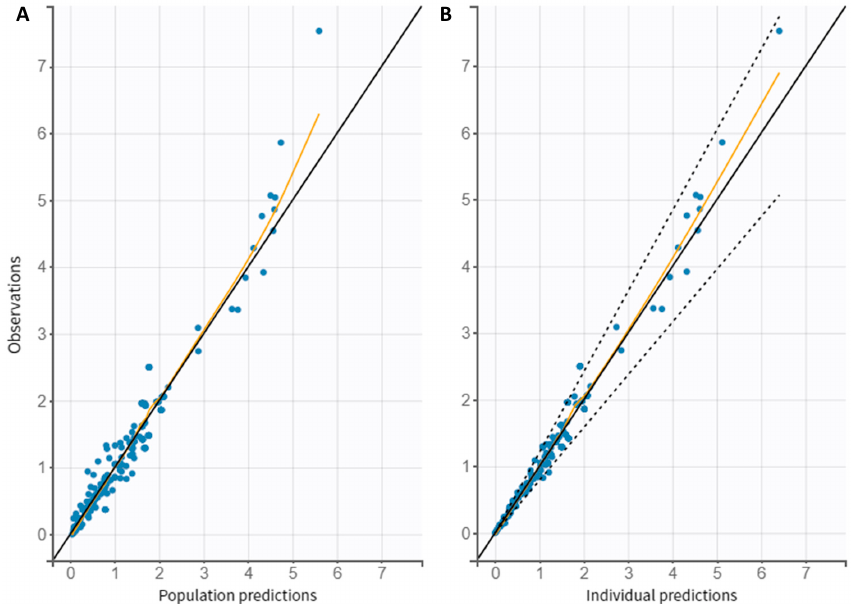
Figure 3. Final NEB covariate pharmacokinetic model. ( A ) Observation vs. Population predictions, and ( B ) Observations vs. Individual predictions of NEB concentration (ng/mL). The line of identity is visualized as a solid black line. The yellow line represents the spline of the data, and the 90% prediction interval is shown as a dotted line.